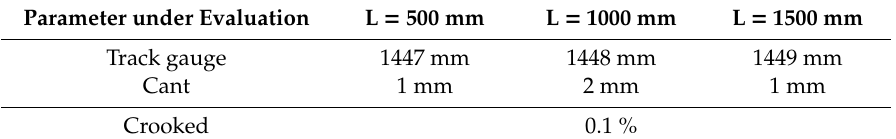
Table 3. Geometrical parameters of the track resulting from the AMBER’s